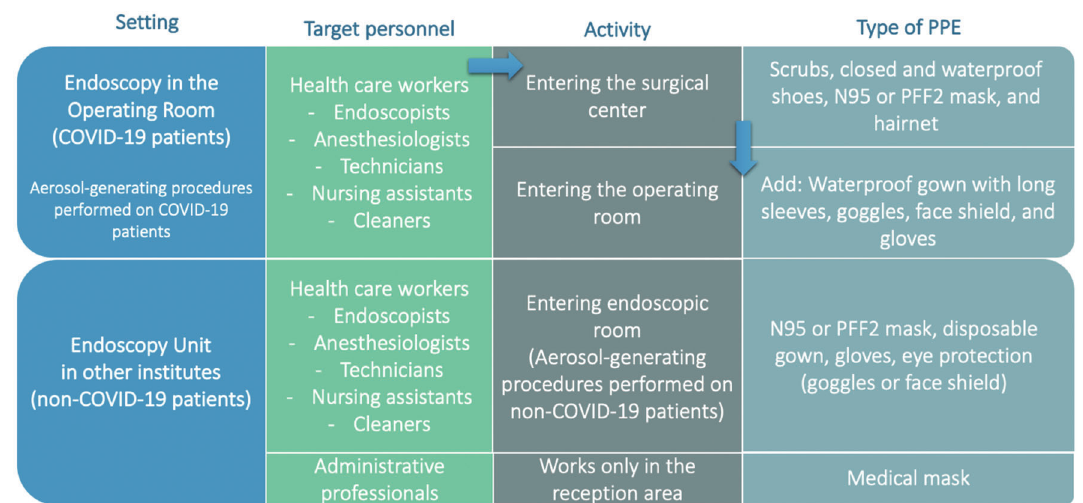
Figure 2 - PPE Recommendations. Adapted from the US Centers for Disease Control and Prevention (CDC) and World Health Organization (WHO) (20,25). Abbreviations: PPE, personal protective equipment; COVID-19, coronavirus disease